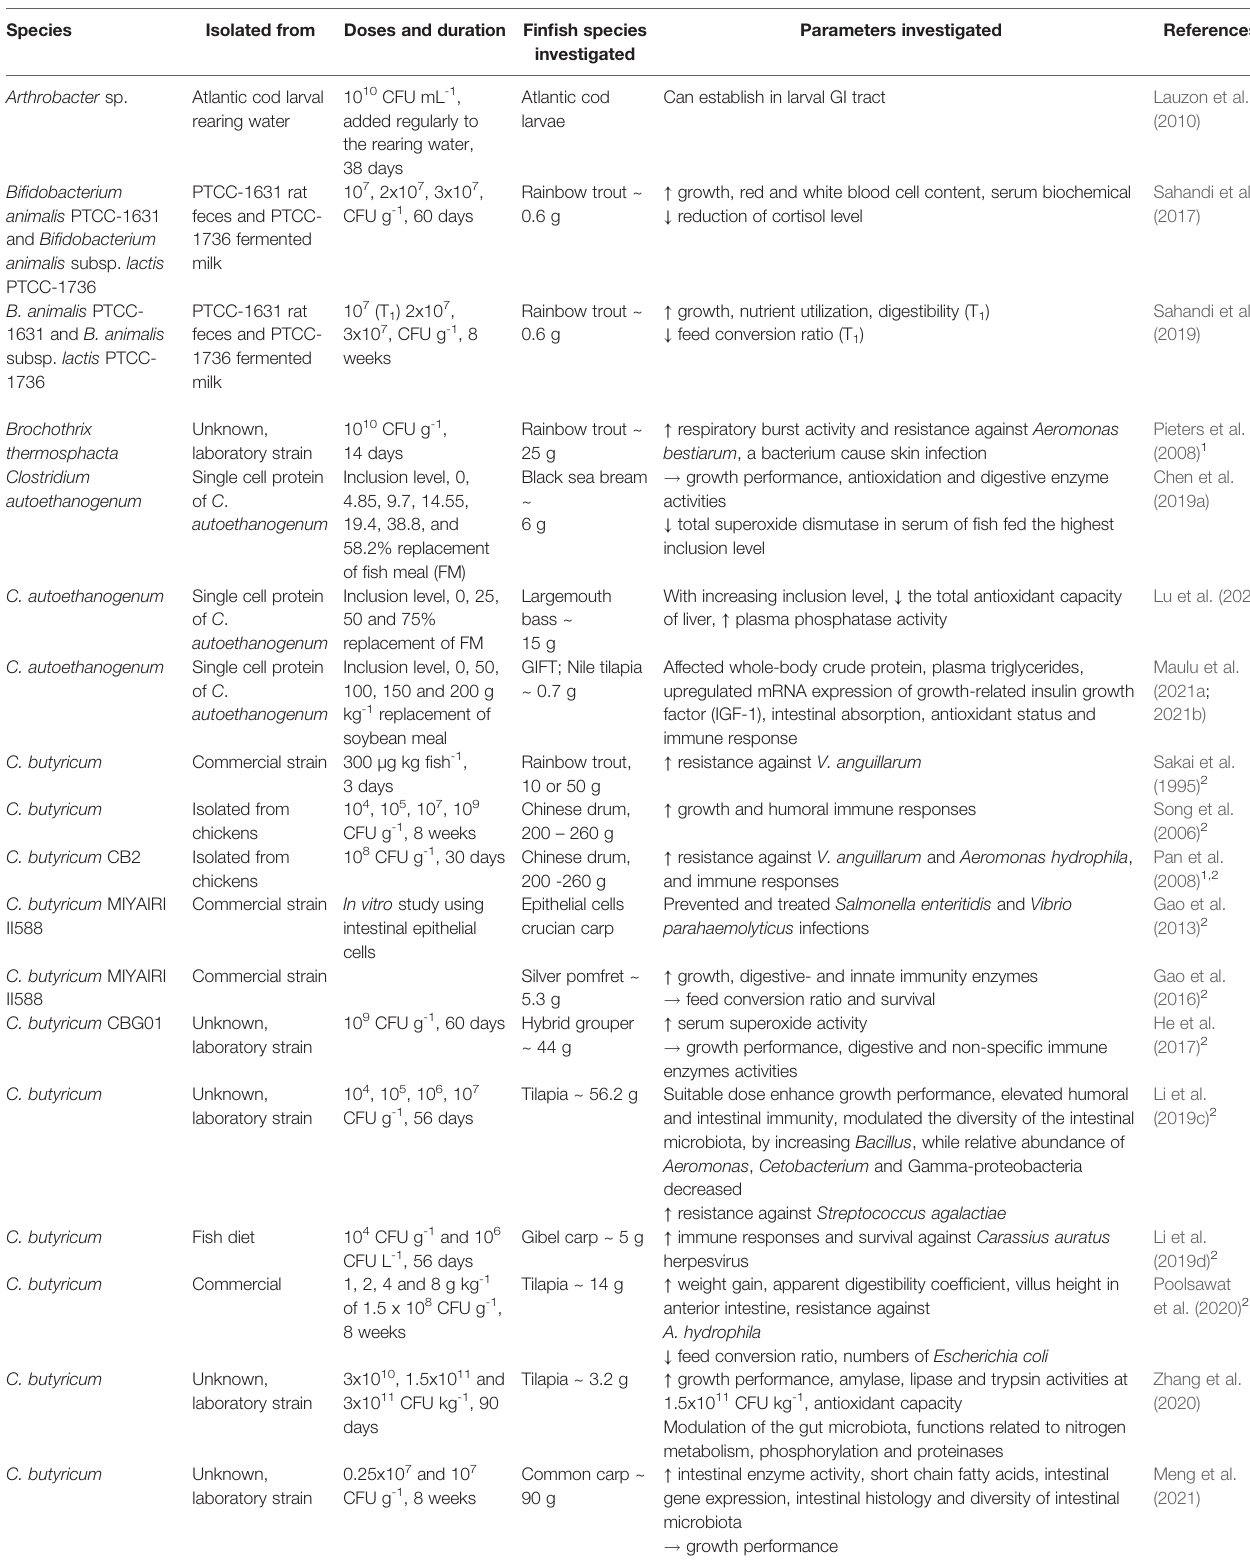
TABLE 2 | Effect of Gram-positive bacteria on growth performance, gut health, immune system and disease resistance in fi n fi sh, and an in vitro study. Species Isolated